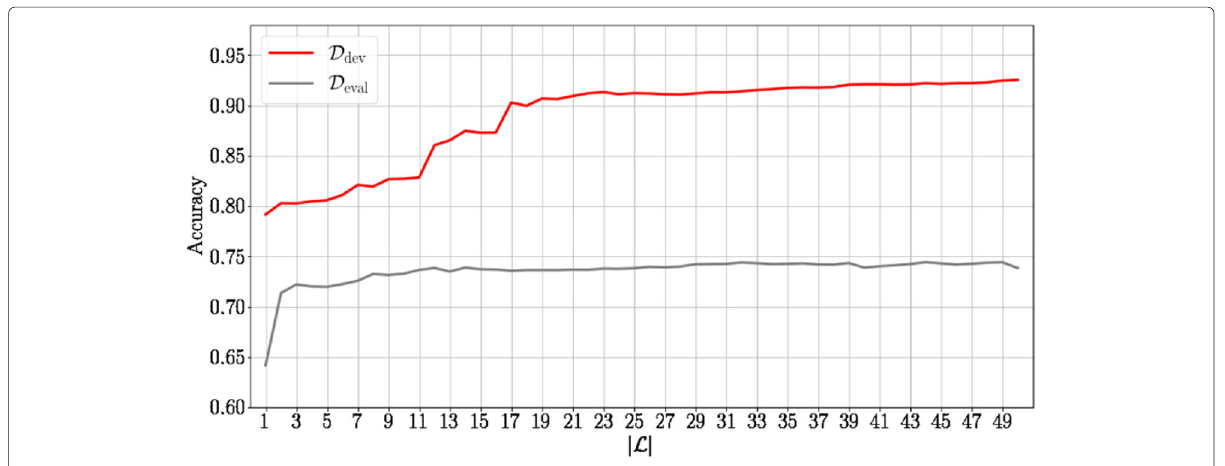
Fig. 3 Accuracy achieved in the binary scenario on D dev and D eval for different cardinalities of